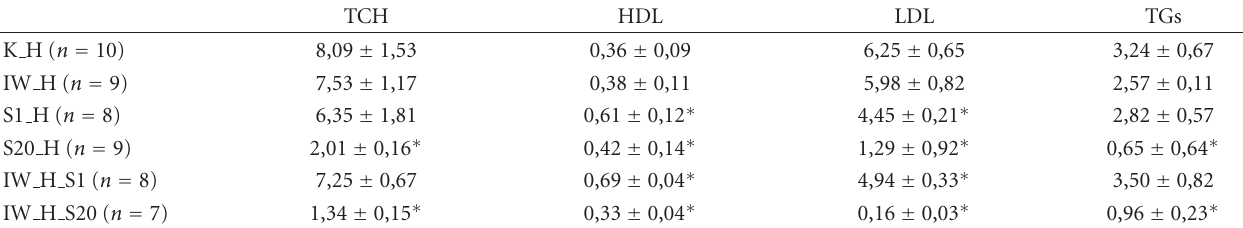
Table 2: Total cholesterol (TCH), HDL-cholesterol, LDL-cholesterol, and triglycerides (TGs) (mean ± SD) in rats fed hypercholesterolaemic diet (mmol/l). TCH HDL LDL TGs K H ( n = 10)